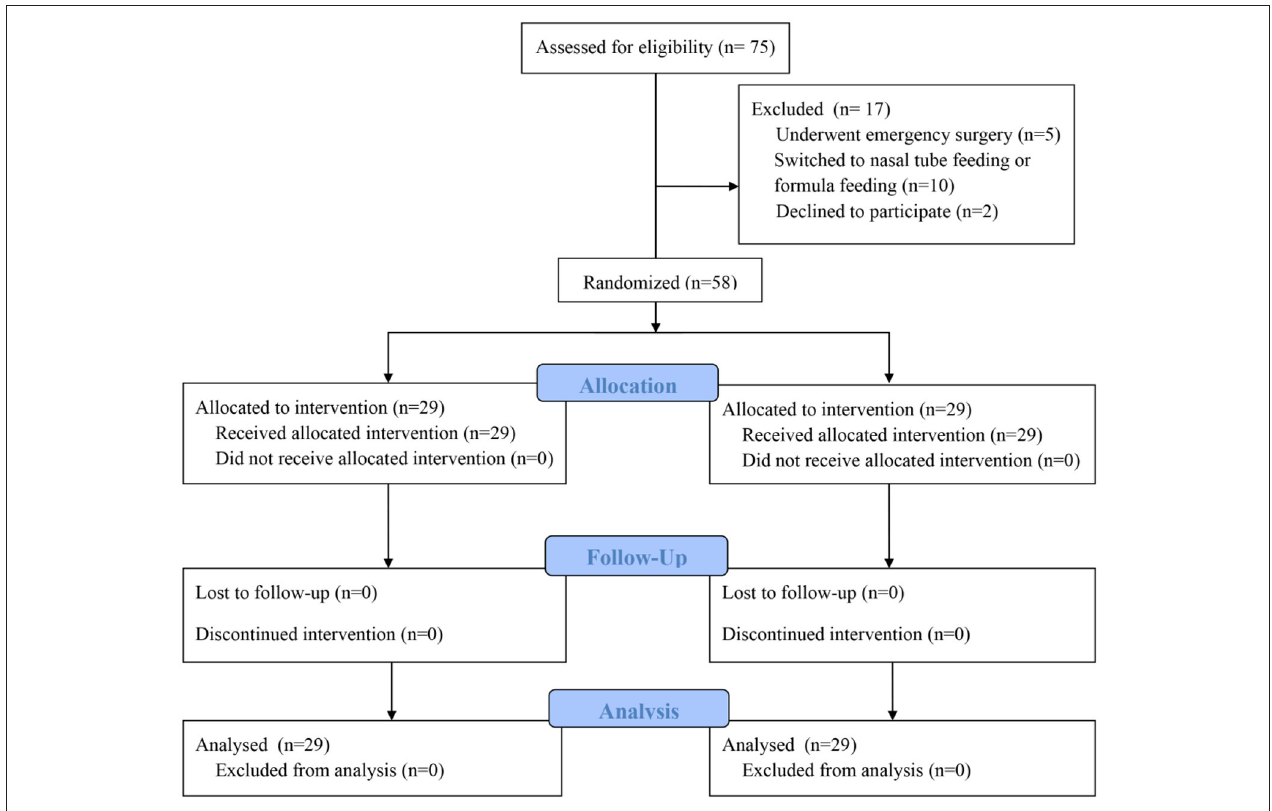
FIGURE 1 | Participants’ CONSORT flow diagram.